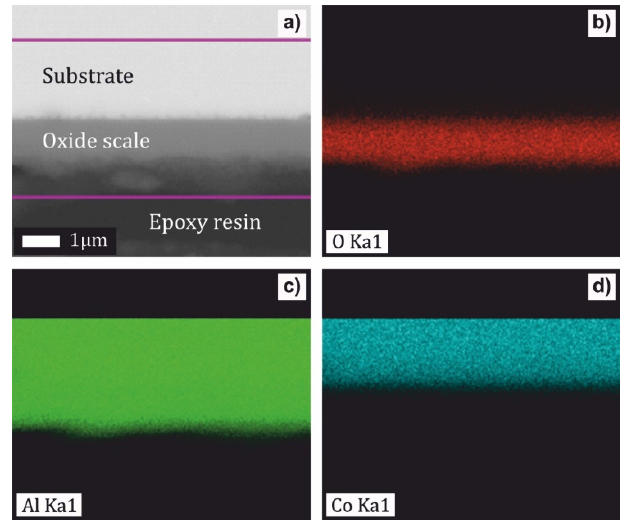
Figure 4. Cross section of the Al 71 Co 29 alloy after oxidation at 1173 K for 30 h ( a ) and energy-dispersive x-ray spectrometer X-max (EDS) element maps for O ( b ), Al ( c ) and Co ( d ).